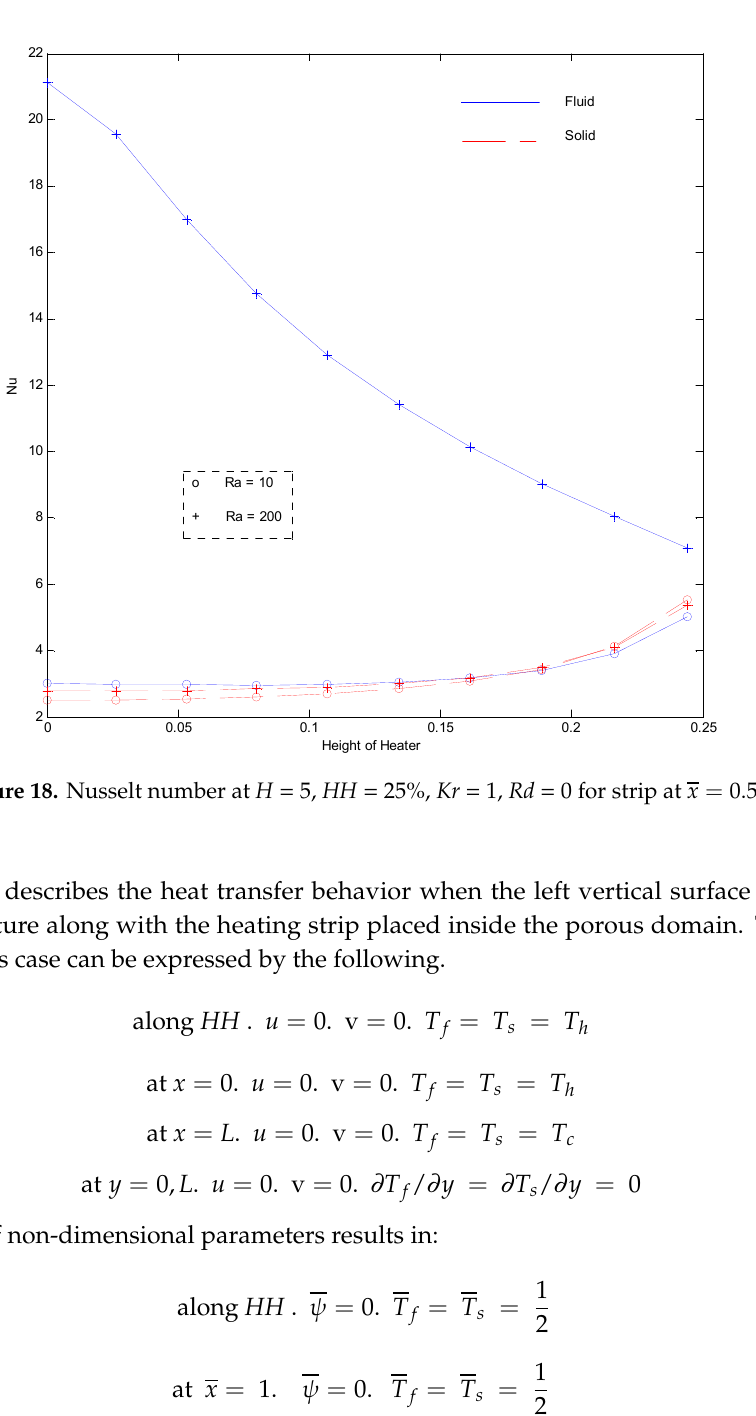
Figure 17. Nusselt number at Ra = 100 , HH = 25% , H = 5 , Rd = 0 for strip at